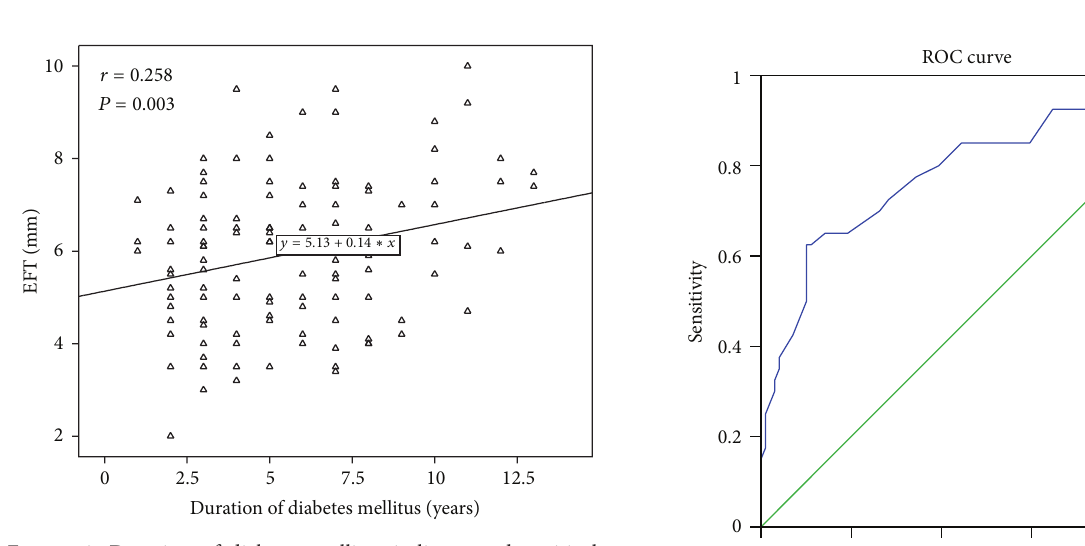
Figure 2: Duration of diabetes mellitus is linear and positively correlated with epicardial fat thickness (EFT).